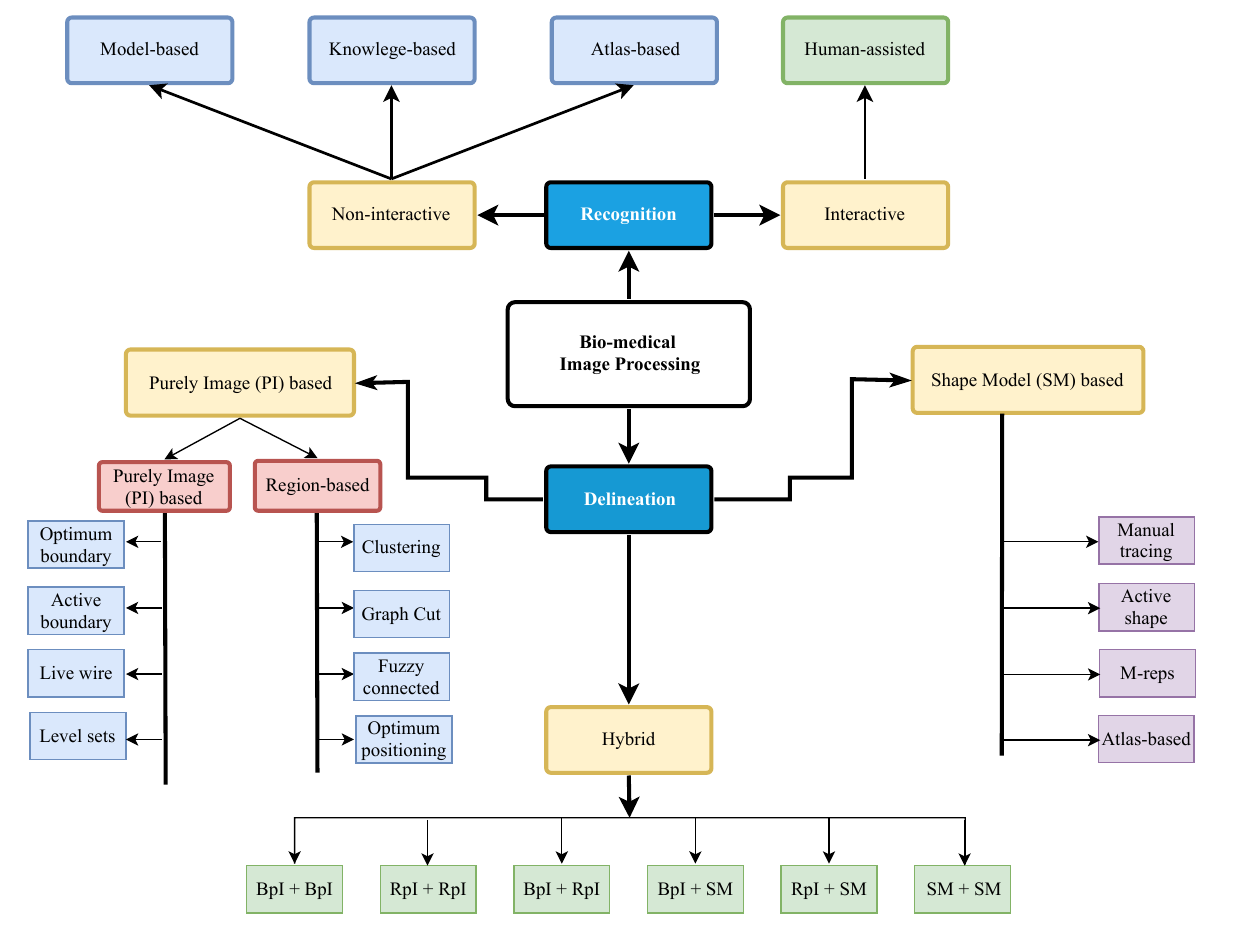
Figure 5. Image recognition and delineation